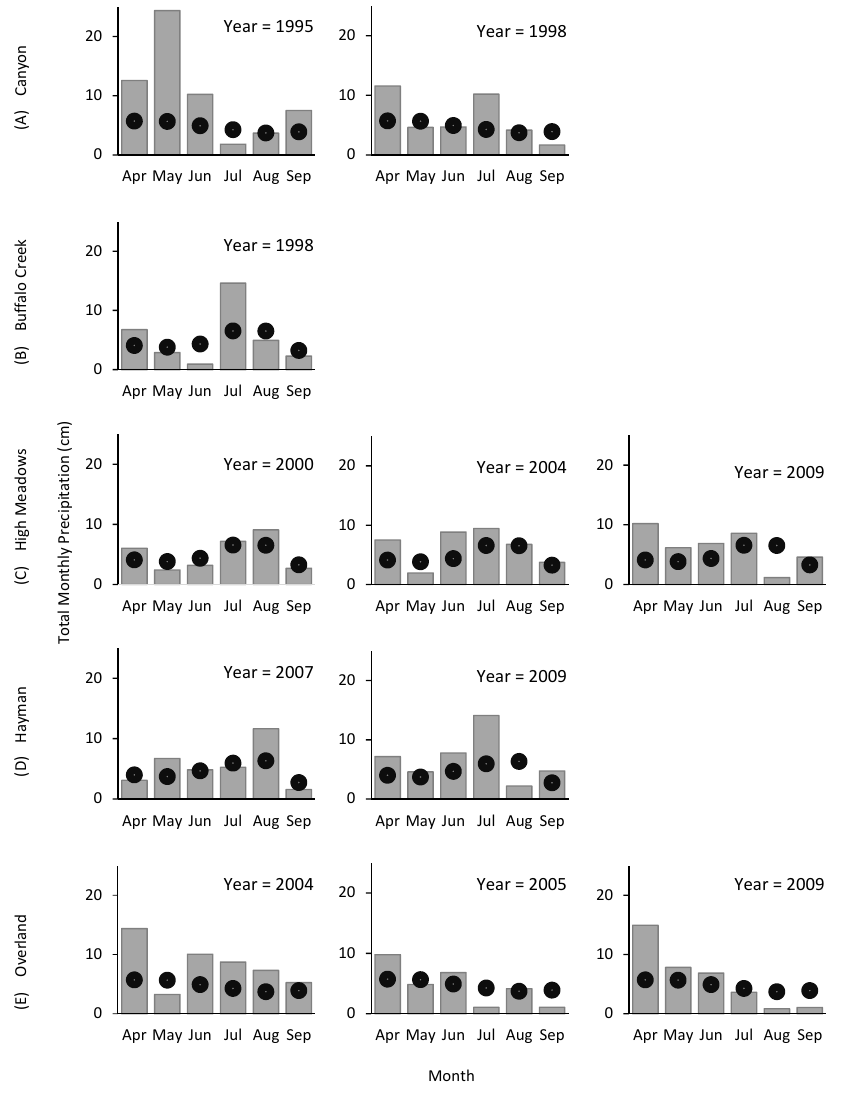
Figure 4. Total monthly precipitation (cm) for the growing season (April–September) during years of episodic establishment at each site (A–E). The dots over the bars represent the monthly mean for the long ‐ term record (1961–2010), for comparison. Establishment years here are years in which a minimum of 20% of all ponderosa pine and Douglas ‐ fir seedlings established.